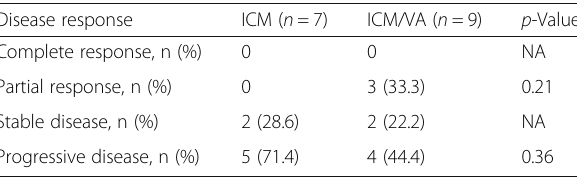
Table 4 Tumour response after treatment with ICM with or without VA therapy Disease